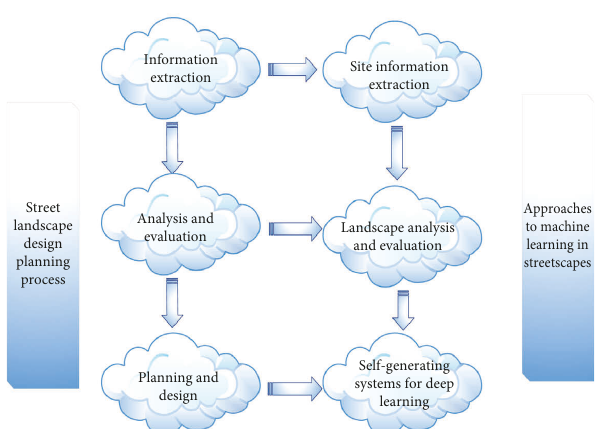
Figure 7: Application of machine learning in